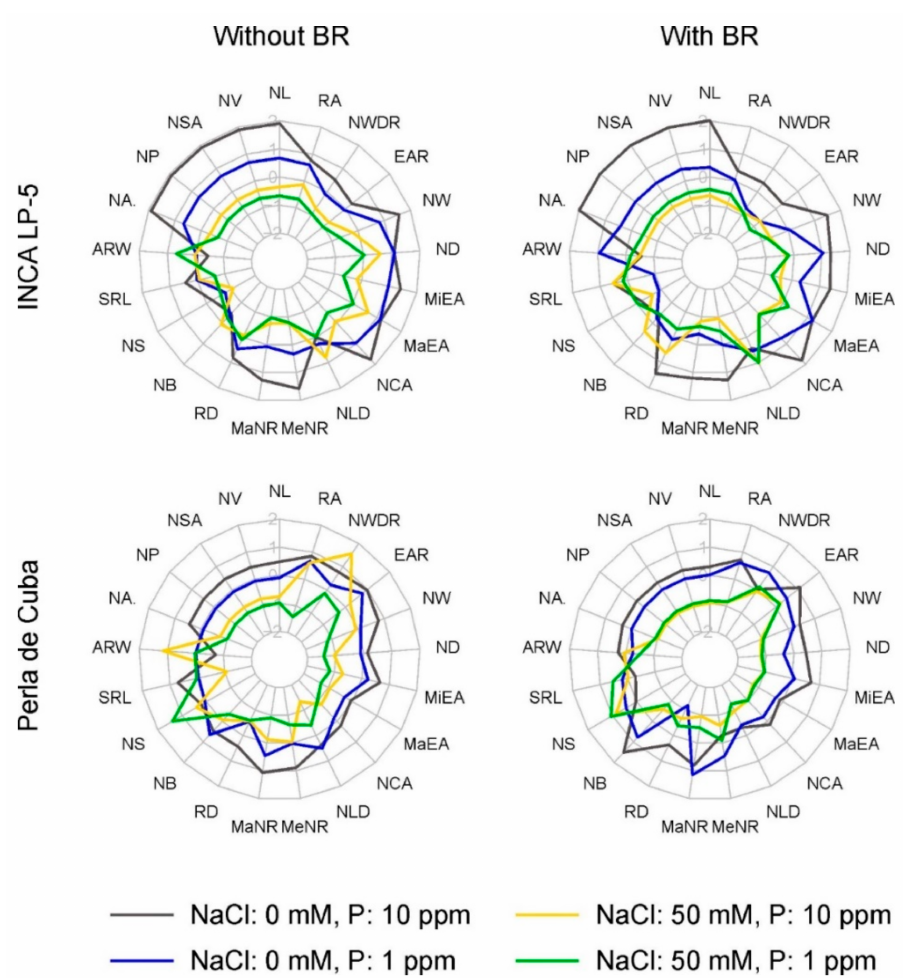
Figure 4. Radar chart of root-system traits (z-score transformation) of the two rice genotypes INCA LP-5 and Perla de Cuba pre-treated with or without 24-epibrassinolide (BR). Grey: control, blue: low P, yellow: high NaCl, green: low P and high NaCl. NL: network length; NV: network volume; NSA: network surface area; NP: network perimeter; NA: network area; ARW: average root width; SRL: specific root length; NS: network solidity; NB: network bushiness; RD: lateral root density; MaNR: maximum number of roots; MeNR: median number of roots; NLD: network length distribution; NCA: network convex area; MaEA: major ellipse axis; MiEA: minor ellipse axis; ND: network depth; NW: network width; EAR: ellipse axis ratio; NWDR: network width-to-depth ratio; RA: root